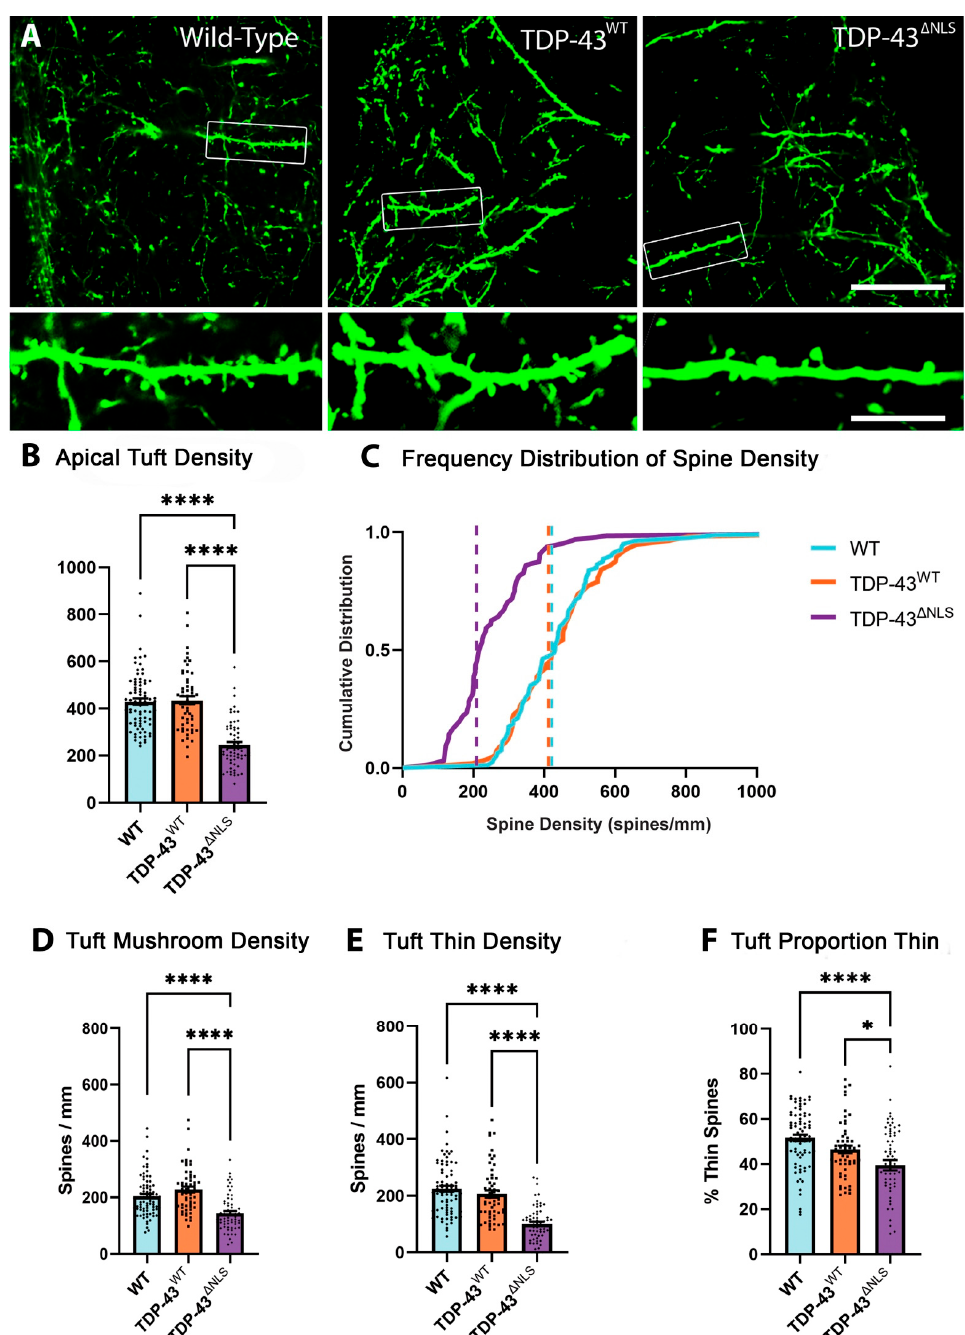
Figure 3. Spines are lost in apical tuft dendrites in TDP-43 ∆ NLS cortical motor neurons. ( A ). Example images of apical tuft dendrites from WT, TDP-43 WT and TDP-43 ∆ NLS layer V pyramidal neurons of the motor cortex that were quantified. ( B ). The density spines on apical tuft dendrites was reduced in TDP-43 ∆ NLS mice compared to WT (F (2, 195) = 53.3, p < 0.0001) and TDP-43 WT mice ( p < 0.0001). ( C ). Frequency distribution of spine density, dashed lines show median density. Almost all TDP-43 ∆ NLS apical tuft dendrites have a density lower than the median WT spine density in apical tuft dendrites. ( D ). The density of mushroom spines was reduced in TDP-43 ∆ NLS apical tuft dendrites compared to WT (F (2, 195) = 22.6, p < 0.0001) and TDP-43 WT mice ( p < 0.0001).( E ). The density of thin spines was reduced in TDP-43 ∆ NLS apical tuft dendrites compared to WT (F (2, 195) = 38.2, p < 0.0001) and TDP-43 WT mice ( p < 0.0001). ( F ) The proportion of thin spines was reduced in TDP-43 ∆ NLS apical tuft dendrites compared to WT (F (2, 195) = 11.84, p < 0.0001) and TDP-43 WT ( p = 0.0326). * p < 0.05, **** p < 0.0001, one-way ANOVA with Bonferroni multiple comparisons. Scale bar = 30 µ m, inset 7.5 µ